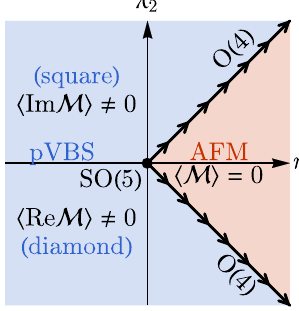
FIG. 7. Phase diagram of the appearance of O(4) DQCP on perturbing the SO(5) theory. Arrows indicate the RG flow